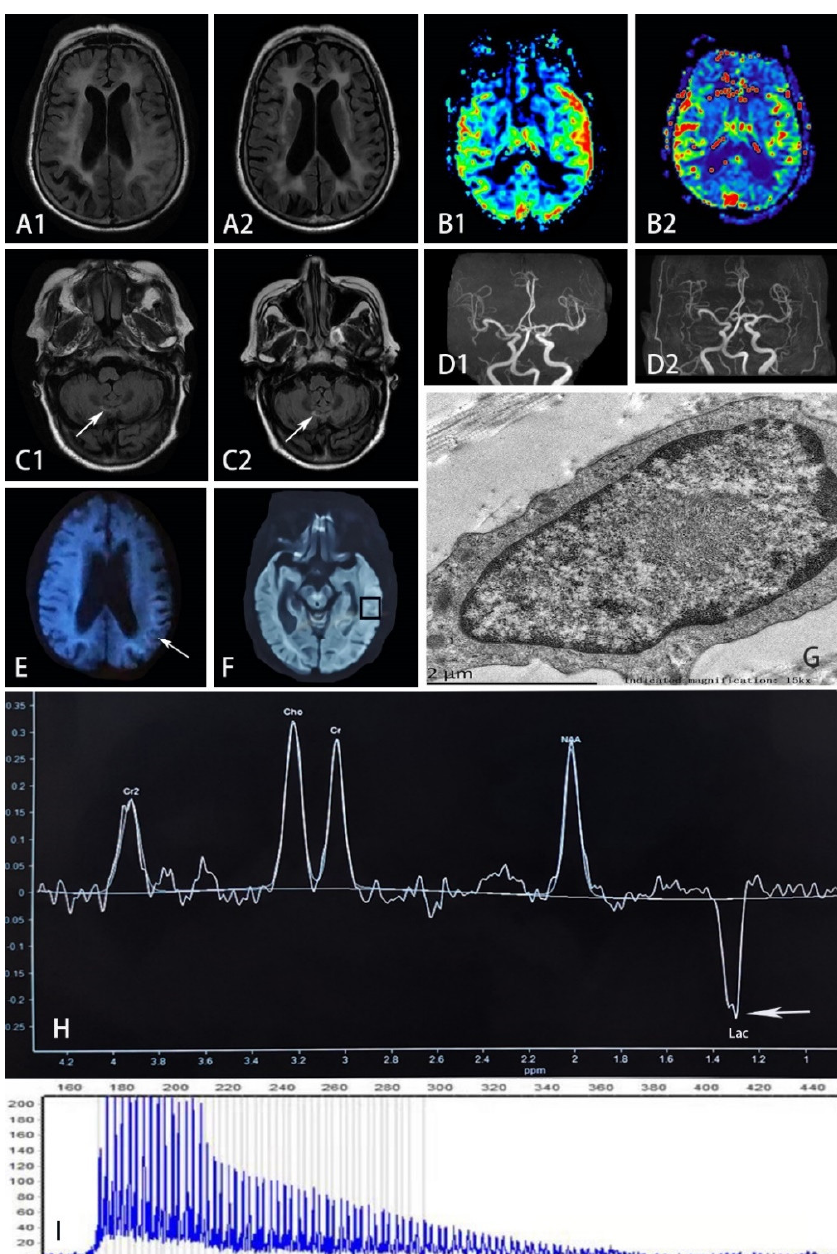
Figure 2. ( A ) FLAIR sequence on November 23rd (in A1) showed hyperintensity and edematous areas in the left temporal and occipital lobes, while such lesions improved 4 months later with reduced hyperintensity and less edema shown in A2. ( B ) PWI on November 23rd (in B1) showed prominent hyperperfusion in accordance with the lesion, but such phenomenon did not present after 4 months with symmetrical blood flow in bilateral temporal lobes shown in B2. ( C ) FLAIR sequence on November 23rd showed hyperintensity on the paravermis area (in C1), which remained the same after 4 months shown in C2. ( D ) MRA on November 23rd (in D1) showed the stenosis of M2 segments of the right middle cerebral artery, which was also presented after 4 months in D2. ( E ) The arrow refers to high-intensity areas in the corticomedullary junction on DWI on November 8th. ( G ) Electron microscopy of mechanocyte showed dense filamentous materials without limiting membrane. ( H ) MRS focusing on the temporal lesion (in ( F )) showed the lactate peak appearance (shown by arrow). ( I ) RP-PCR showed GGC expansion in the patient. (FLAIR, fluid-attenuated inversion recovery; PWI, perfusion-weighted image; DWI, diffusion-weighted image; MRA, mag- netic resonance angiography; MRS, magnetic resonance spectroscopy; RP-PCR, repeat-primed PCR; Lac,